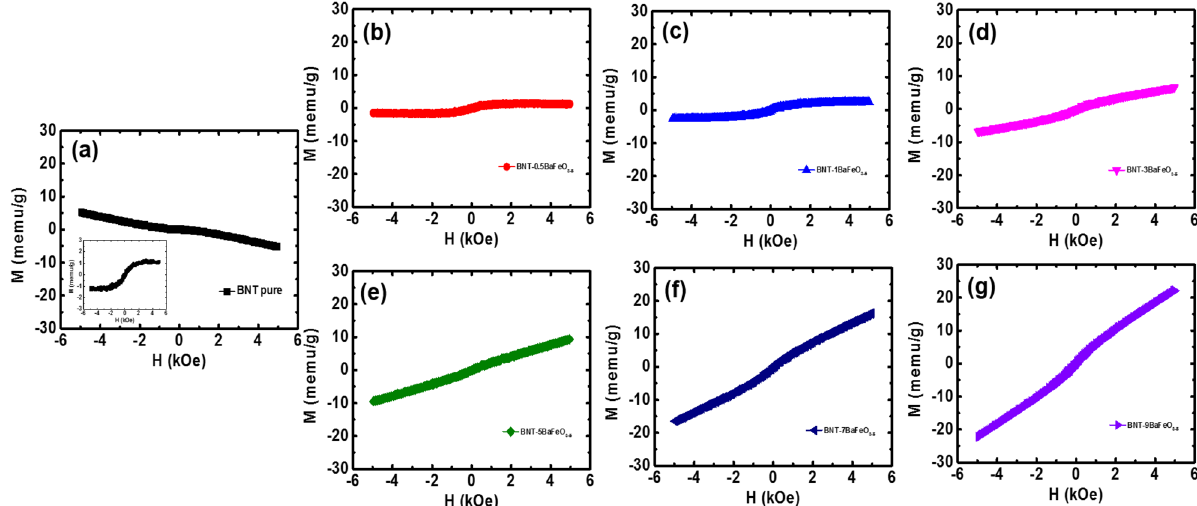
Figure 7. M – H curves at room temperature of (a) undoped Na 0.5 Bi 0.5 TiO 3 , and BaFeO 3− δ -modified Na 0.5 Bi 0.5 TiO 3 samples with (b) 0.5 mol%, (c) 1 mol%, (d) 3 mol%, (e) 5 mol%, (f) 7 mol% and (g) 9 mol% BaFeO 3− δ as solid solution. Inset of (a) shown the M-H curve of pure Bi 0.5 Na 0.5 TiO 3 material after substrate diamagnetic generated from absorbance photon energy, thereby prevented the recombination of the electron–hole pairs to generate photons. Furthermore, the role of BaFeO 3−δ solid solution in Na 0.5 Bi 0.5 TiO 3 materials in imparting magnetism was dependent on the applied magnetic field at room temperature, as shown in Fig. 7a–g for pure Na 0.5 Bi 0.5 TiO 3 and BaFeO 3−δ -modified Na 0.5 Bi 0.5 TiO 3 materials with BaFeO 3−δ concentration of 0.5, 1, 3, 5, 7 and 9 mol%, respec- tively. The pure Na 0.5 Bi 0.5 TiO 3 exhibited the anti- S -shape in M-H curves, indicating the combination of diamag- netism and weak ferromagnetism, as shown in Fig. 7a. The diamagnetism in pure Na 0.5 Bi 0.5 TiO 3 samples origi- nated from the electronic configuration of Ti 4+ as 3 d °, whereas the weak ferromagnetism originated from self-def ects 9–11,14,16,30,64,65 . The typical hysteresis loop of ferromagnetism was obtained for pure Na 0.5 Bi 0.5 TiO 3 materials after subtract the diamagnetic components, as shown in inset of Fig. 7a. The saturation magnetization was esti- mated around 1.5 memu/g which were well consisted with recently reported by Ju et al. 16 . In addition, the remanent magnetization ( M r ) and coercive field ( H C ) of pure Na 0.5 Bi 0.5 TiO 3 materials were approximately 0.11 memu/g and 73 Oe, respectively, which were solid evidence for presentation of ferromagnetic state at room temperature. The estimation for their values were also performed with recently reported by Thanh et al. and Ju et al. which those were possibly originated from self-defect such as Na-, Ti- or O-vacancies 10,16 . The M-H curves trend to switch from anti- S -shape to S -shape in the BaFeO 3−δ -modified Na 0.5 Bi 0.5 TiO 3 samples as the BaFeO 3−δ concentration in the solid solution increase, providing evidence regarding the strength enhancement of ferro- magnetic ordering in the samples. As shown in Fig. 7c, the typical ferromagnetic hysteresis loops were obtained where the magnetization trended to saturate as the external applied magnetic field increase, and the strength of ferromagnetic increase. However, further increasing amounts of BaFeO 3−δ into host Na 0.5 Bi 0.5 TiO 3 , the M-H curves exhibited the unsaturation with low applied external magnetic field, as shown in Fig. 7d–g. The depend- ence of shape in magnetic hysteresis loop of BaFeO 3−δ -modified Na 0.5 Bi 0.5 TiO 3 materials represented that the magnetic properties of BaFeO 3−δ -modified Na 0.5 Bi 0.5 TiO 3 materials were very complex, on the one hand the magnetic properties of Na 0.5 Bi 0.5 TiO 3 materials were strong dependent of the concentration of BaFeO 3−δ as solid solution. The M r and H C values of BaFeO 3−δ -modified Bi 0.5 Na 0.5 TiO 3 materials were approximately 51–106 Oe and 0.12–0.48 memu/g, respectively. These results were consistent with the recently observed M r and H C of transition-metal-doped lead-free and lead-based ferroelectric materials 8–11,60,64–68 . The nonzero M r and H C values of BaFeO 3−δ -modified Bi 0.5 Na 0.5 TiO 3 materials provided solid evidence for the presence of the ferromagnetic state at room temperature. In additon, the maximum magnetization was estimated around 23 memu/g for 9 mol% BaFeO 3−δ solid solution in host Na 0.5 Bi 0.5 TiO 3 materials. That value was larger than that of self-defect induced magnetism of pure Na 0.5 Bi 0.5 TiO 3 materials or single transition metals doped Na 0.5 Bi 0.5 TiO 3 materials, in which around ~ 1.5 memu/g for Cr-doped Na 0.5 Bi 0.5 TiO 3 , ~ 3 memu/g for Co-doped Na 0.5 Bi 0.5 TiO 3 , ~ 9 memu/g for Mn-doped Na 0.5 Bi 0.5 TiO 3 , ~ 15 memu/g for Fe-doped Na 0.5 Bi 0.5 TiO 3 materials, and ~ 4 memu/g for Ni-doped Na 0.5 Bi 0.5 TiO 3 materials 8–11,60,68 . Herein, we need to remark that the origin of ferromagnetism ordering of transi- tion metal impurities containing Na 0.5 Bi 0.5 TiO 3 materials at room temperature were still debated. The weak- ferromagnetism in pure Na 0.5 Bi 0.5 TiO 3 materials were possibly originated from self-defect and/or surface defect (such as Ti and Na-vacancies) while the magnetization of Na 0.5 Bi 0.5 TiO 3 materials were slightly enhanced via oxygen vacancies 11,14,16,30 . The Mn-, Ni- and Fe-doped Na 0.5 Bi 0.5 TiO 3 materials exhibited the room temperature ferromagnetism which were related to intrinsic phenomenon where the transition cations such of Mn, Ni and Fe interacted with the oxygen vacancies, like F- center interaction mechanism, e.g. Mn 2+/3+ –¤–Mn 2+/3+ or Fe 2+/3+ –¤–Fe 2+/3+ pairs etc., which were favored for ferromagnetic ordering 8–11,60,64 . Unlikely Mn-, Ni- and